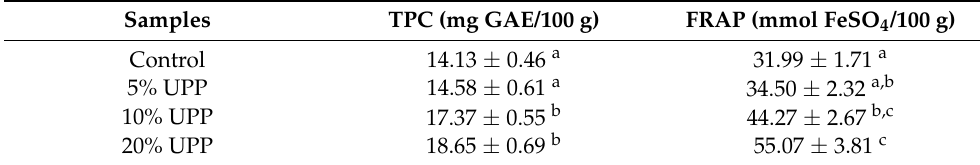
Table 4. Texture analysis and color profiles of pancakes with unripe papaya powder.